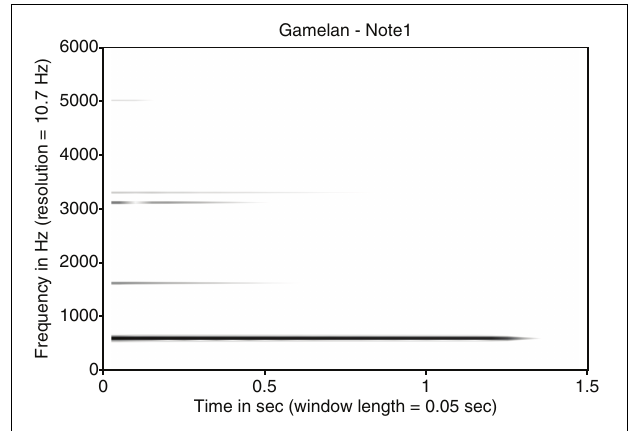
FIGURE 1 | Spectrogram of a note from the Gangsa instrument. The spectrogram shows a lowest frequency partial at 599Hz and three inharmonic partials at ∼ 1621, 3114, and